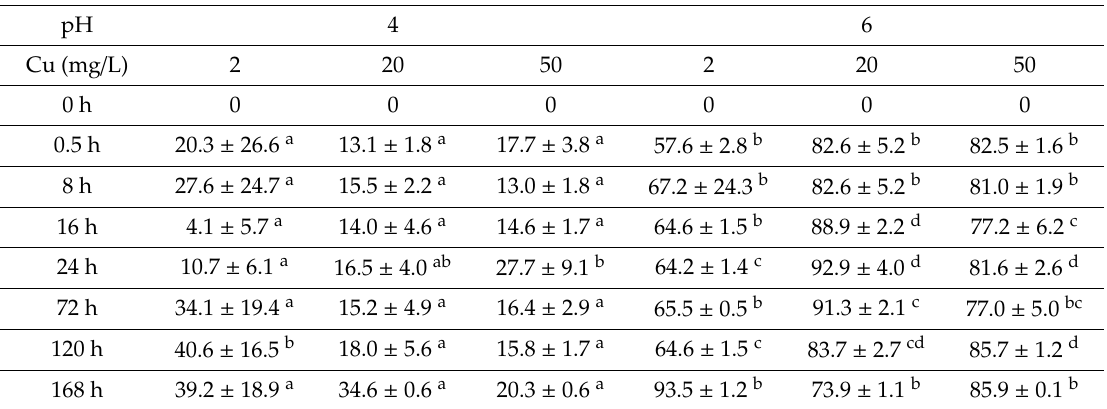
Table 1. Percent removal of copper from growth media containing Desmodesmus sp. AARLG074 over 168 h (7 days) growth at pH4 and pH6. Each value represents the mean ± SD ( n = 3) with different superscript letter in the same time point indicating statistically significant differences (Two-way ANOVA, Tukey HSD, p < 0.05) using R version 3.4.3.